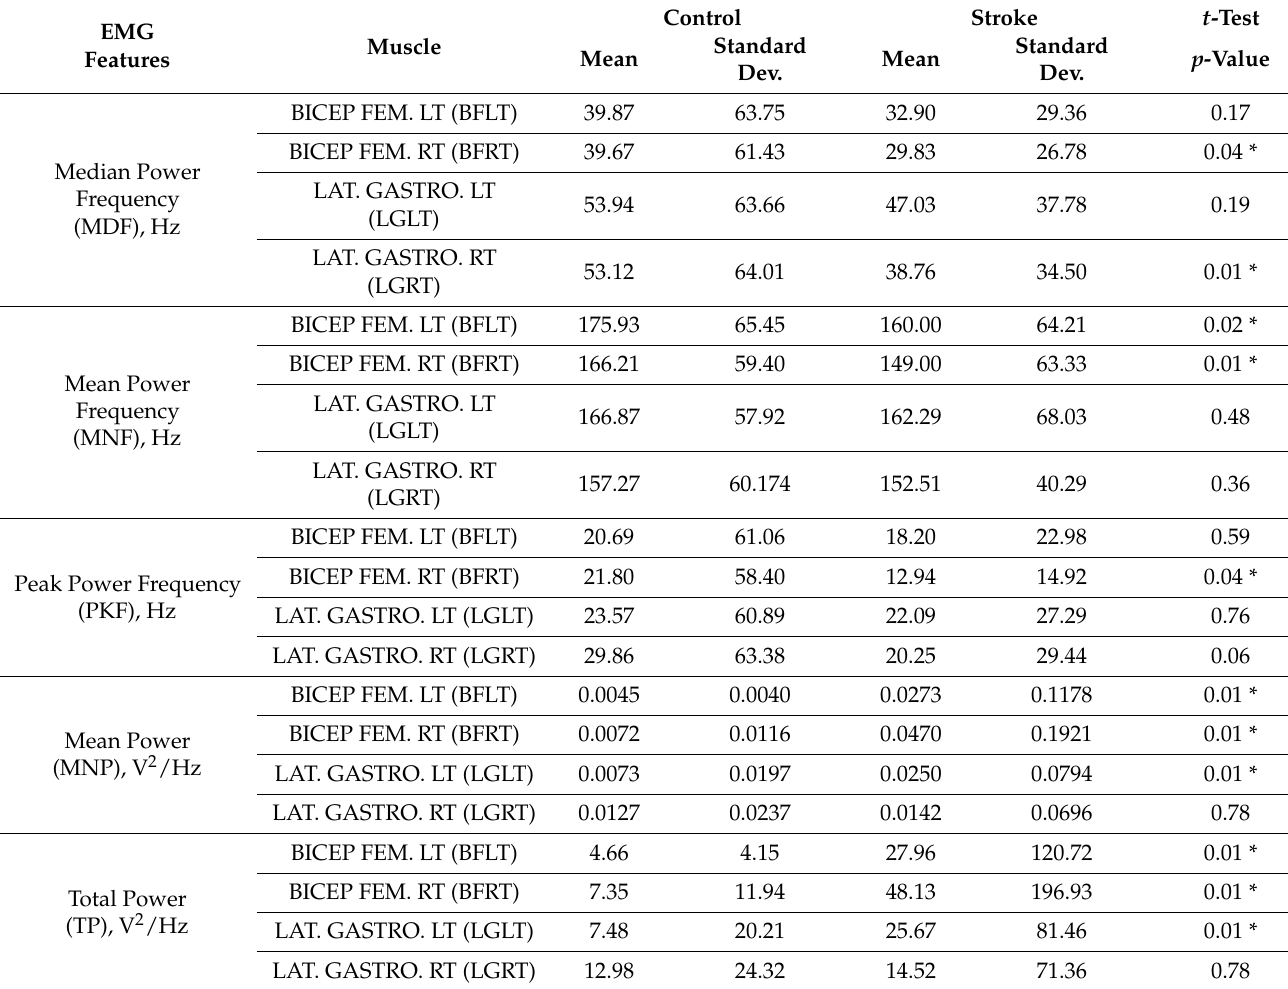
Table 1. Results of the statistical analysis of the EMG features of the control and the stroke group. * Indicates p < 0.05. EMG